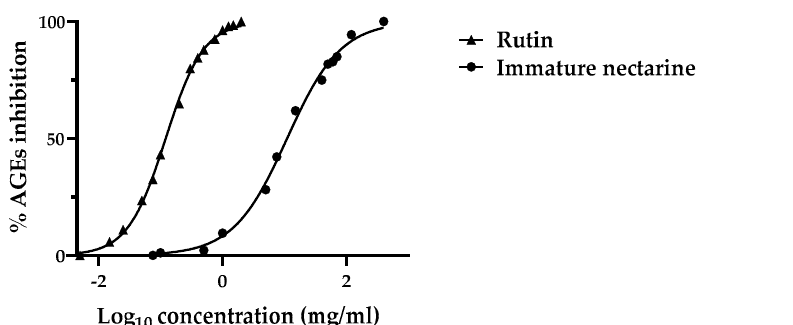
Figure 3. Inhibition of Advances Glycation End-Product formation (%) by Thinned Nectarine and rutin. Values represent mean ± standard deviation of triplicate readings.